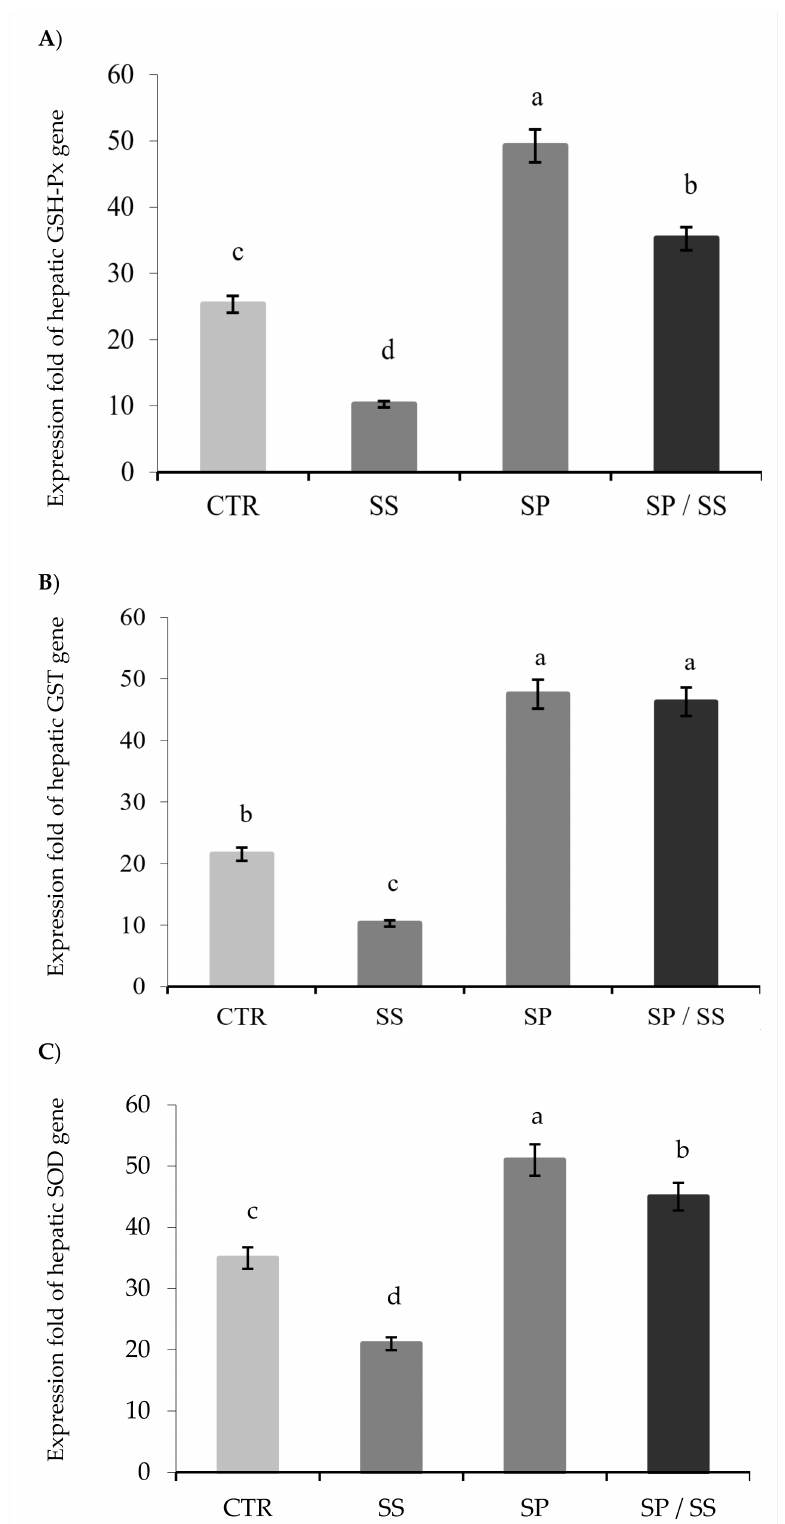
Figure 4. Relative expression of the hepatic antioxidant genes ( A ) GSH-Px, ( B ) GST, and ( C ) SOD in Nile tilapia after sodium sulphate (SS) exposure and fed diets with or without S. platensis (SP) for 8 weeks. a,b,c,d = letters on top of the bars show that the groups are significantly di ff erent from those in the control group (CTR) ( p <